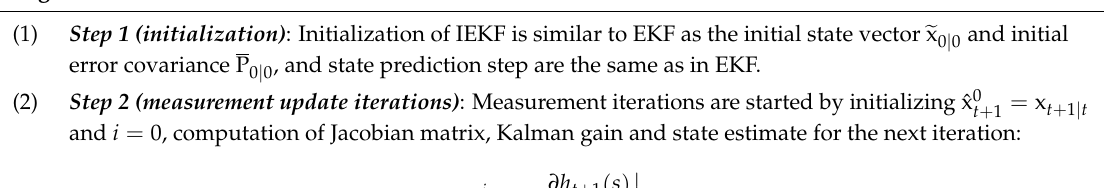
Algorithm 1. IEKF estimation model